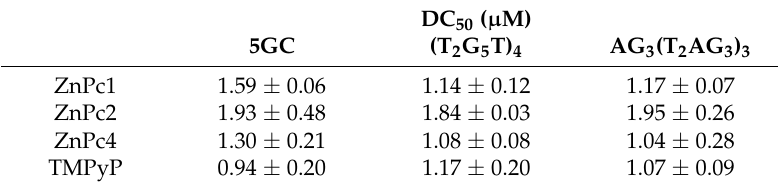
Figure 8. G4-FID assay performed in PBS at 25 °C with (T 2 G 5 T) 4 (green squares), (AG 3 (T 2 AG 3 ) 3 ) (blue circles), duplex (5GC) (red triangles) and ( A ) ZnPc1, ( B ) ZnPc2, ( C ) ZnPc4, ( D ) TMPyP. Table 4. DC 50 values obtained for studied ligands in PBS at 25 °C.